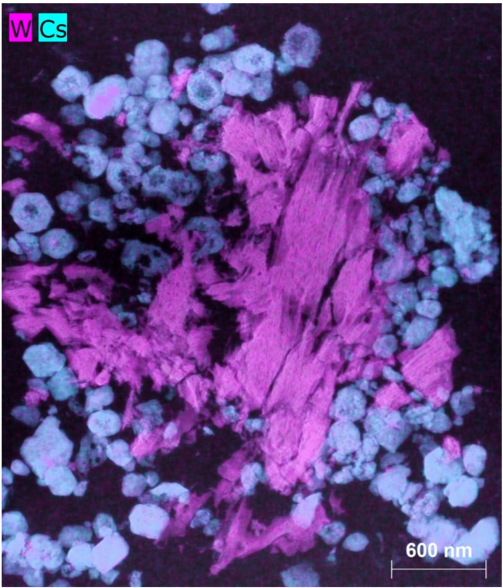
Figure 3. TEM-EDX micrograph recording of A_Cs 0.6 P 0.6 . Cyan color: HPA phase, magenta color: